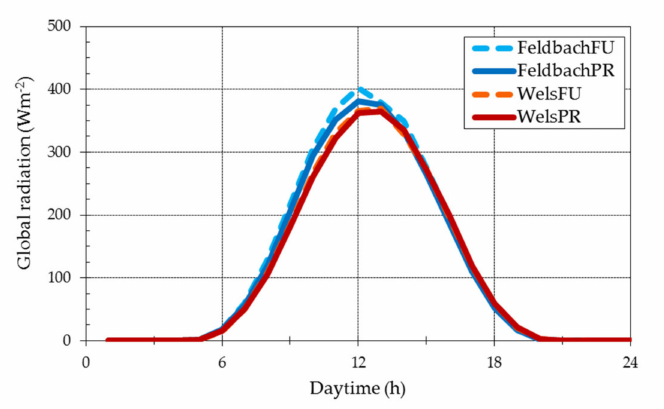
Figure 2. Annual mean of the daily course of global radiation for Feldbach and Wels (PR = present (1981–2010), FU = future